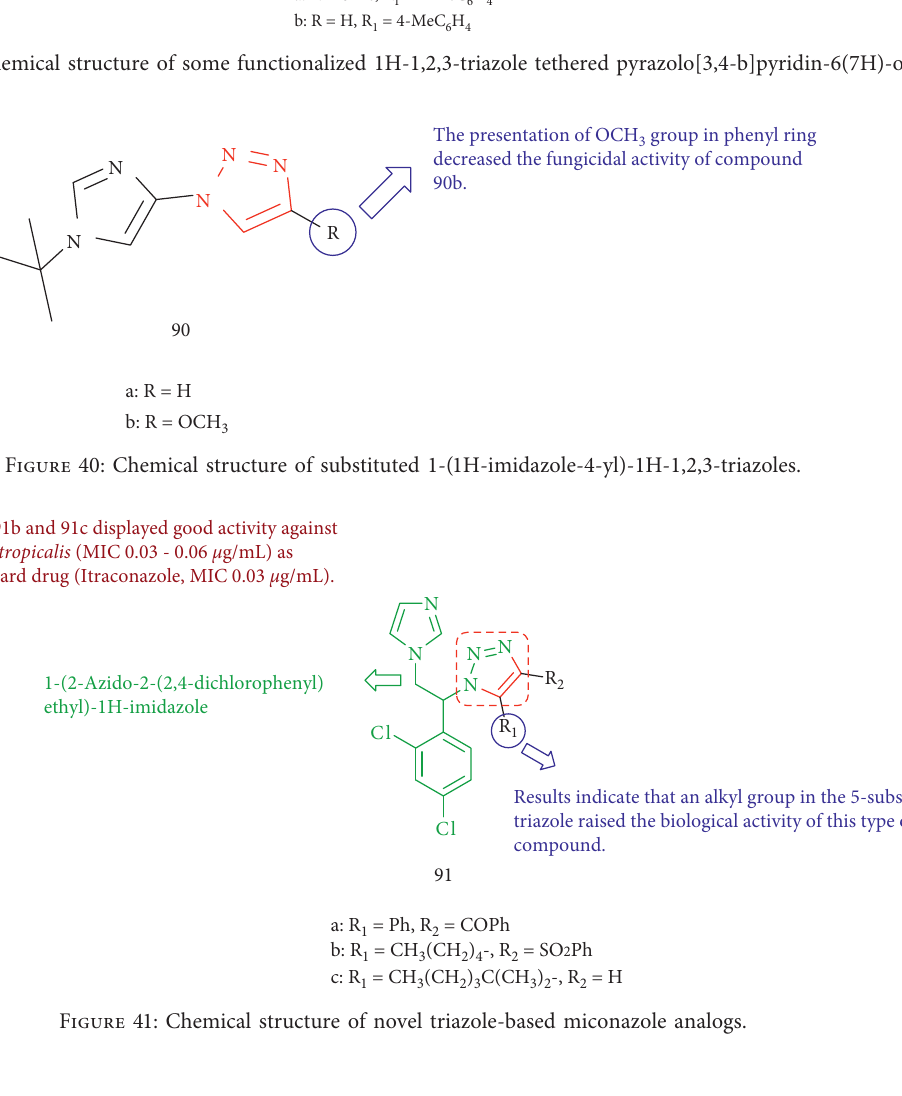
NN R 1 N NNMe Ph